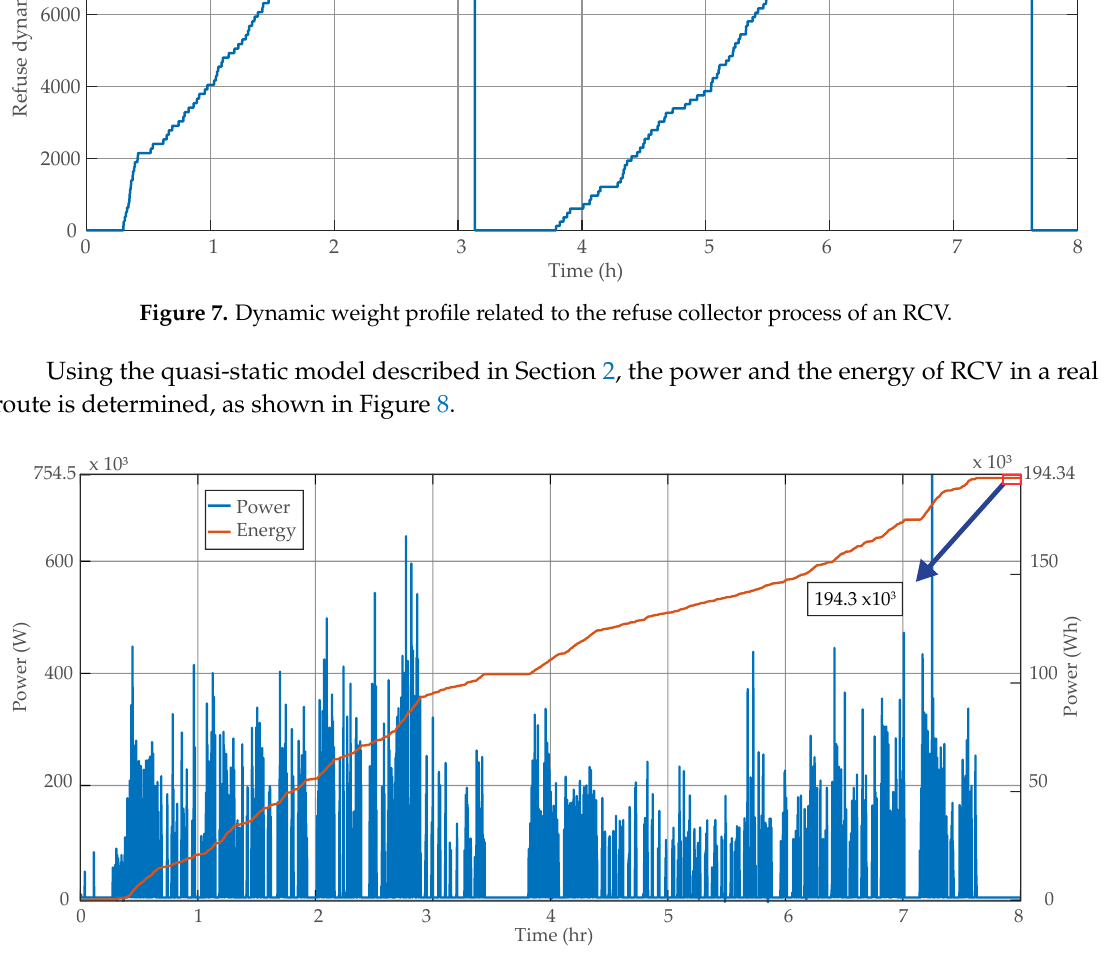
Figure 8. Power and energy for an HE – RCV taking into account a real drive